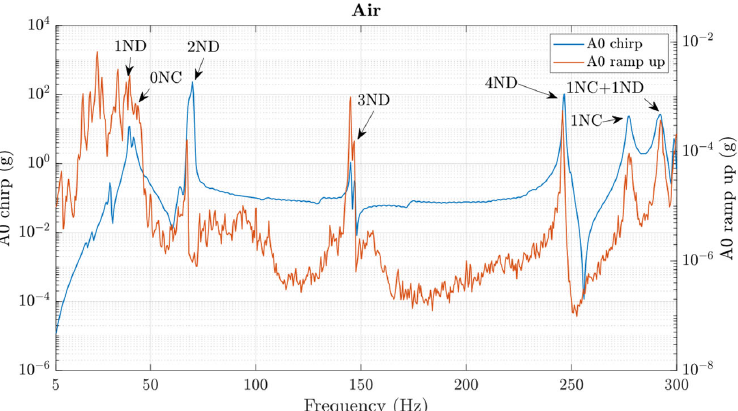
Figure 18. Maximum spectra of the STFT of A0 when exciting the disk with a chirp applied using the PZT patch, in blue, or using a ramp-up, in orange, in air.